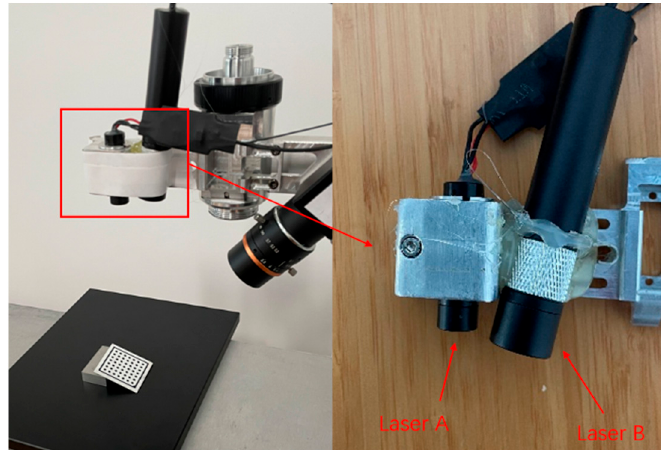
Figure 7. Calibration board and gauge blocks.